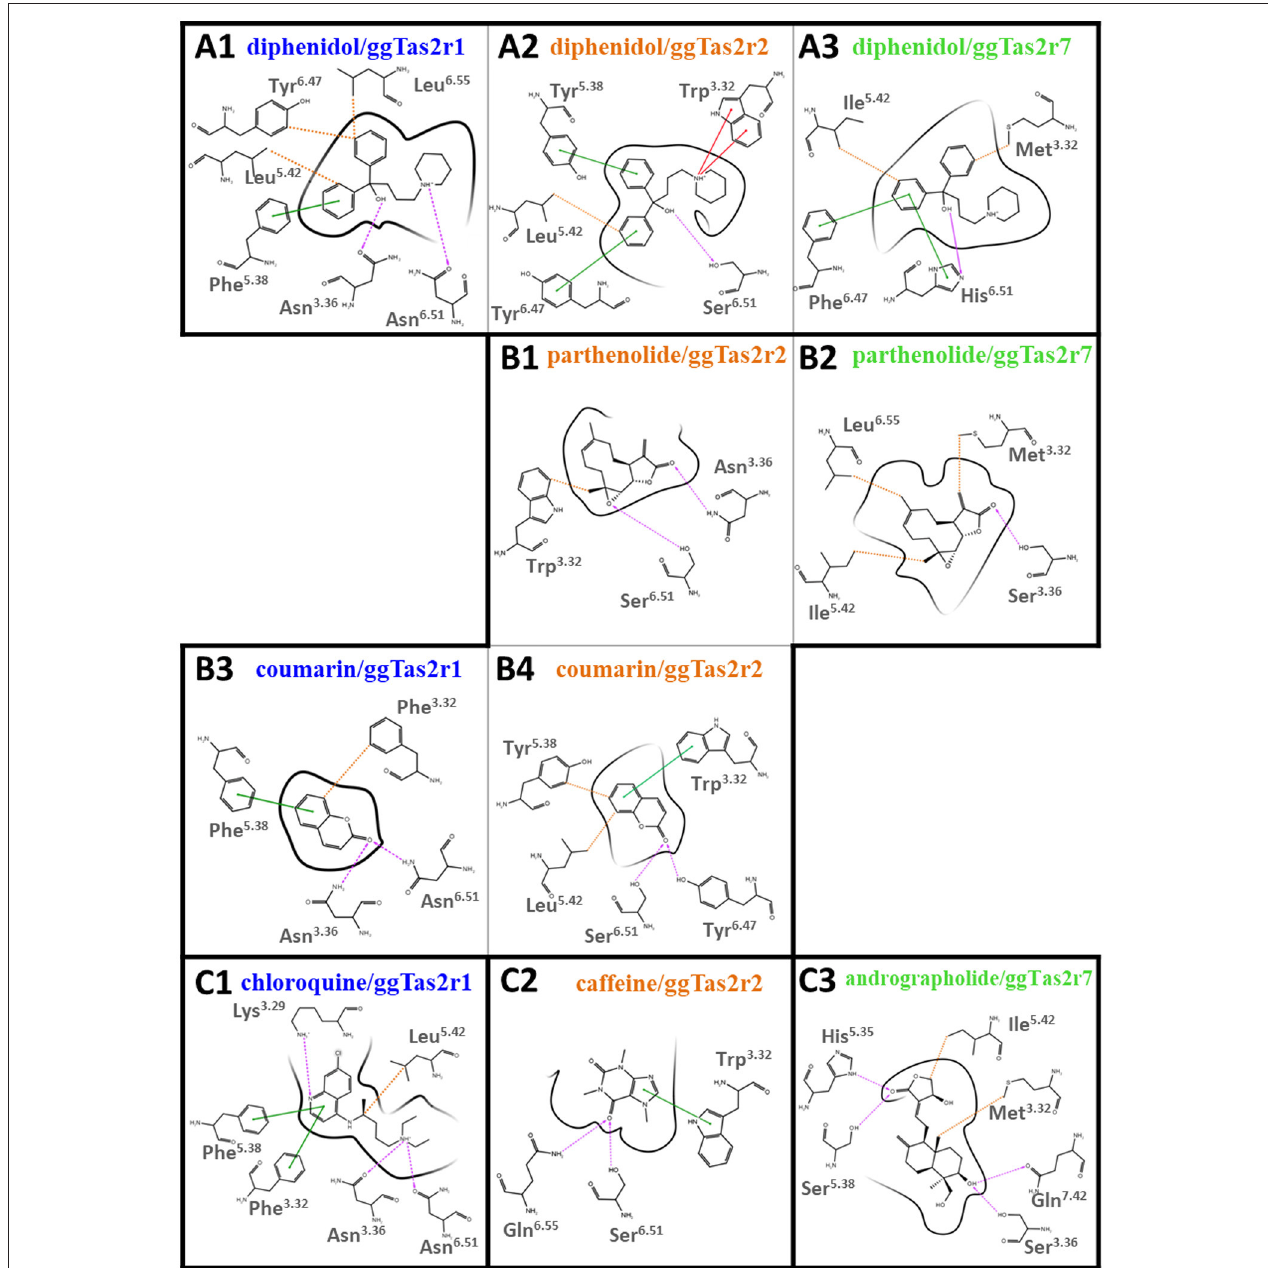
FIGURE 2 | 2D representation of predicted binding modes of promiscuous (A) , intermediate-promiscuous (B) and selective compounds (C) into the ggTas2r binding sites. H-bond interactions are shown as magenta dashed arrows, π - π interactions as green lines, cation- π interactions as red lines and hydrophobic interactions are represented as the distances between the closest heavy atoms of the ligand and the residue as orange dotted lines. Binding modes of diphenidol, coumarin, and chloroquine into ggTas2r1 have been described in our previous work (Di Pizio et al.,